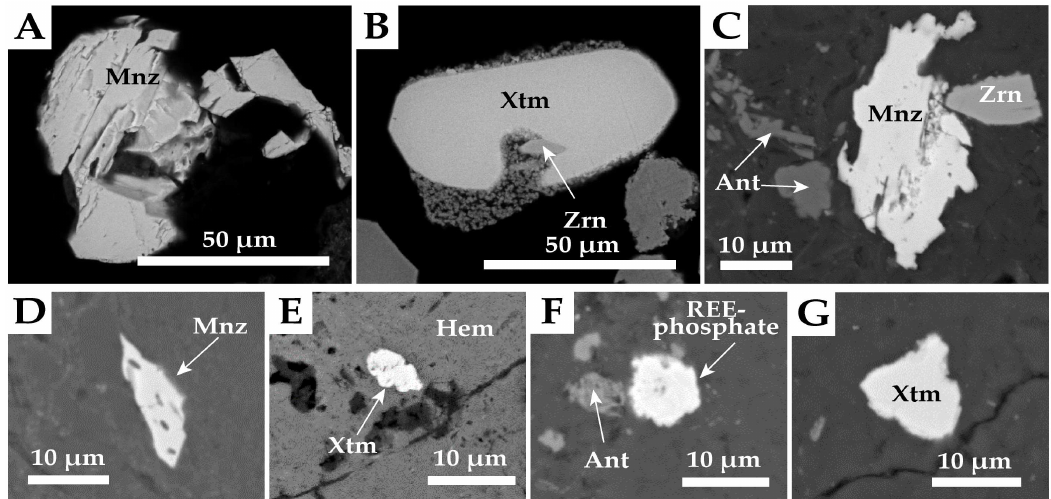
Figure 8. Backscattered-electron (BSE) images of REE-phosphates found in bauxitic ores from the CCR. ( A , B ) Monazite-(Ce) and xenotime-(Y) grains recovered from heavy mineral concentrates. The monazite-(Ce) crystal shows a sharp, irregular outline and abundant scratches. The xenotime-(Y) crystal is subhedral and shows slightly rounded and locally embayed outlines and pyramidal termination; it contains a small-sized zircon grain. ( C – G ) Monazite-(Ce) and xenotime-(Y) grains discovered in thin sections. ( C ) Textural relationships between an anhedral monazite-(Ce) grain floating in the kaolin mineral-rich matrix along with a zircon and several anatase grains. ( D ) Minute anhedral monazite-(Ce) grain embedded in the kaolin mineral-rich matrix. ( E ) Minute xenotime-(Y) grain hosted by porous hematite. ( F ) REE-phosphate with a concentric texture and intergrowth with the kaolin mineral-rich matrix. ( G ) Anhedral xenotime grain with an alteration rim. Mnz = monazite-(Ce), Xtm = xenotime-(Y), Zrn = zircon, Ant = anatase, Hem = hematite. Minerals 2017 , 7 , x FOR PEER REVIEW Representative Raman spectra of REE-phosphates using a 532 nm wavelength laser are given in Figure 9. The comparison of a Raman spectrum obtained in a monazite-(Ce) grain with a reference spectrum [56] of this mineral reveals a good correlation between bands at ~969 and ~1057 cm −1 . The comparison of a Raman spectrum obtained in a xenotime-(Y) grain with a reference spectrum [56] of this mineral yields a good correlation between bands at ~997, ~1022 and ~1053 cm −1 , as well as in the range from 300 to 700 cm −1 . The Raman bands at ~1000 cm −1 correspond to the characteristic PO 4 - stretching vibrations [57].